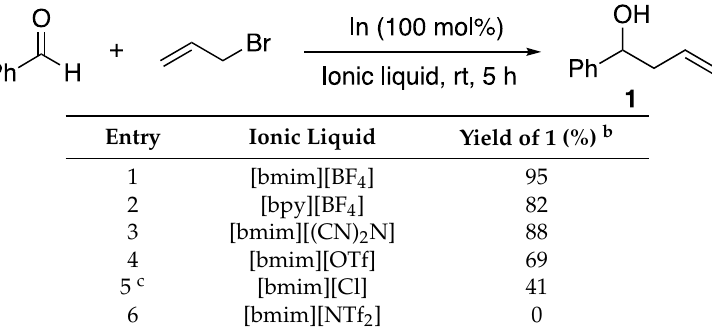
Table 1. Indium ‐ mediated allylation in ionic liquid. a